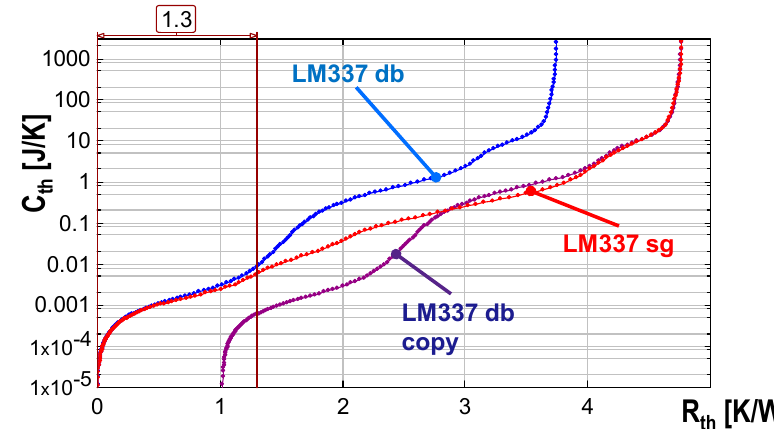
Figure 17. Z th curves of stabilizer IC in TO-220 package: single gauge and double gauge.